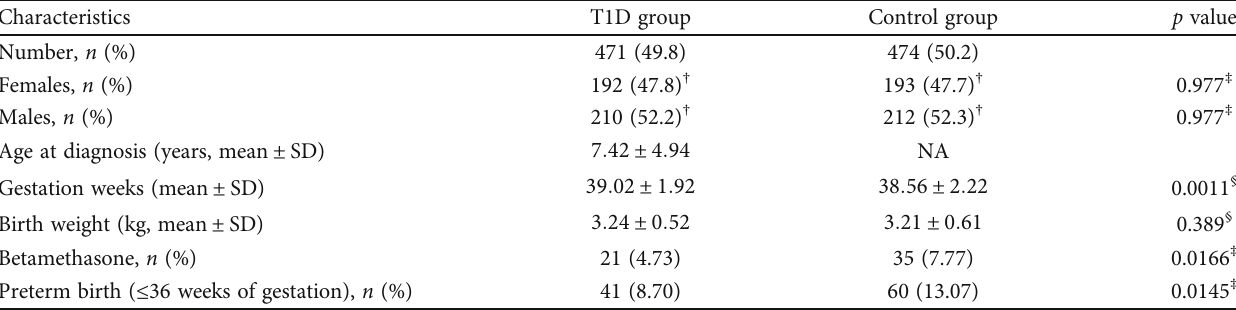
Table 1: Clinical characteristics of the subjects in the study and control